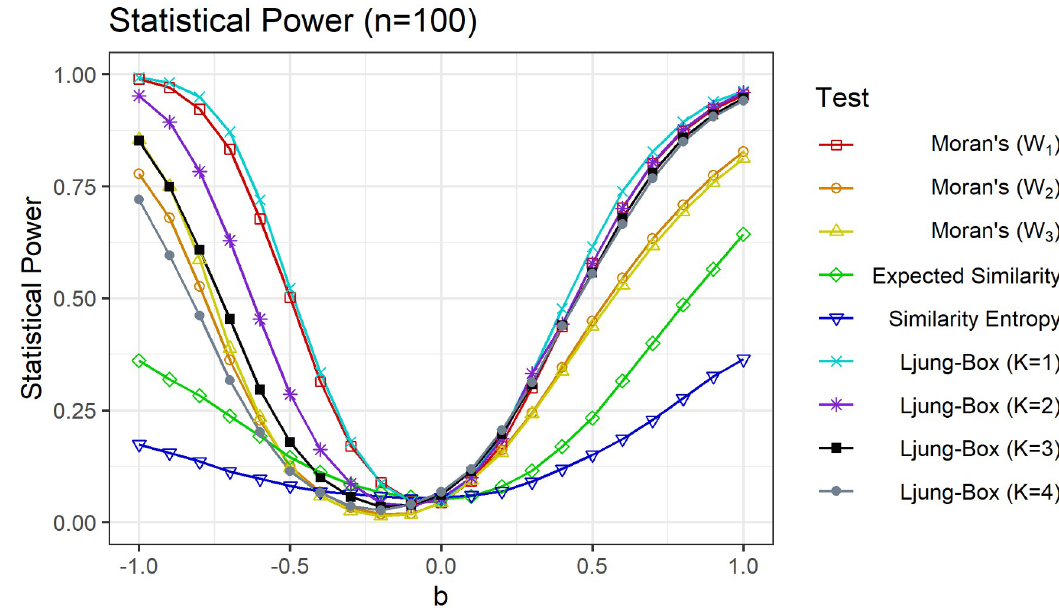
Fig 2. Statistical power vs. network autocorrelation. Statistical power of the network Ljung-Box test for network lags K = 1, 2, 3, 4 compared to expected similarity, similarity entropy and Moran’s I tests for n = 100 and − 1.0 � b � 1.0.